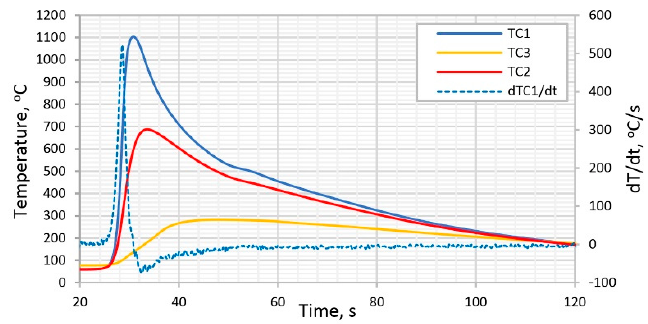
Figure 4. Thermal cycle obtained during the welding of a S960MC steel butt weld joint.